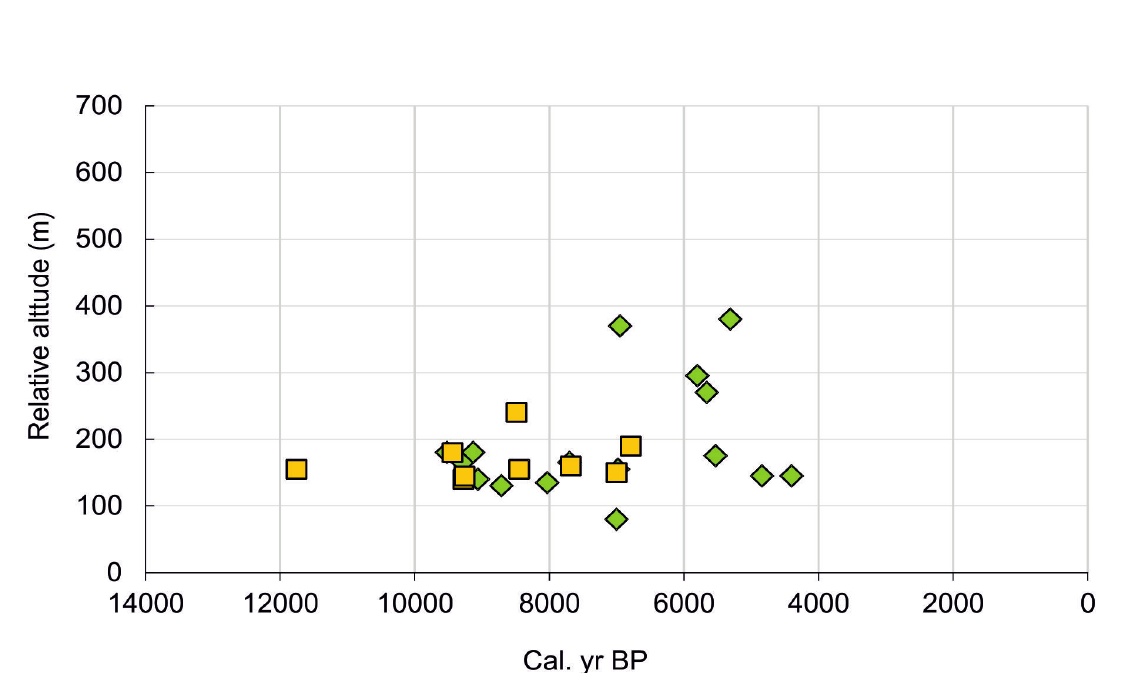
Figure 35: Radiocarbon dates of birch (green) and pine (yellow) megafossils, relative to the present-day position of the birch treeline (zero). Abisko (8-12).